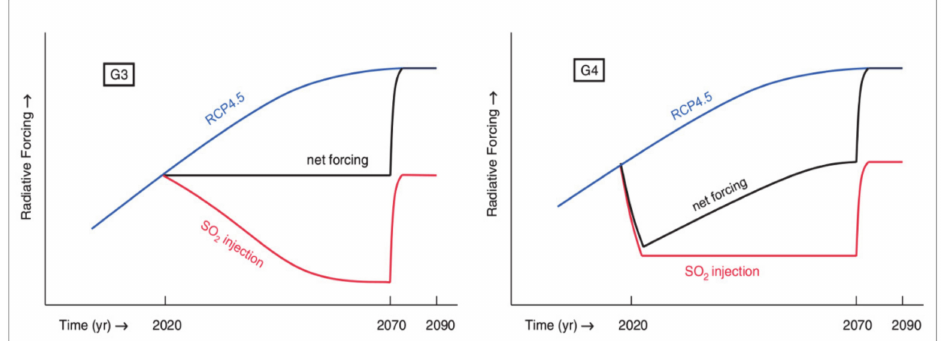
Figure 2. Geoengineering Model Intercomparison Project (GeoMIP) scenarios. The G3 experiment is configured to approximately balance positive radiative forcing from representative concentration pathway 4.5 (RCP4.5) by injecting SO 2 into the tropical lower stratosphere. The G4 experiment produces immediate negative radiative forcing by injecting SO 2 into the tropical lower stratosphere at a rate of 5 Tg per year. Adapted from